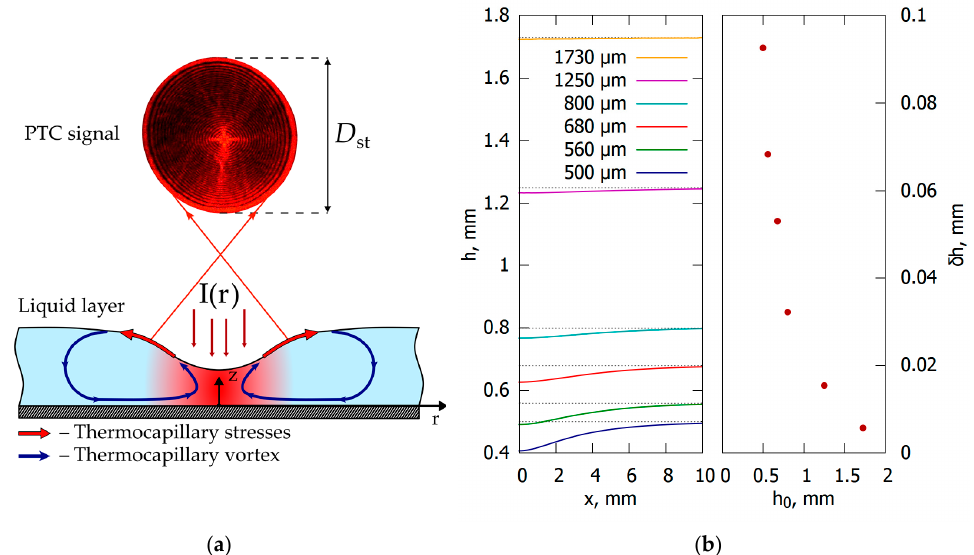
Figure 2. ( a ) Schematic of the thermocapillary convection in a liquid layer locally heated with a laser beam, I ( r ). A thermocapillary concave deformation of the interface in the heated spot and the pho- tothermocapillary signal (PTC signal) formation by a reflected laser radiation; ( b ) typical profiles of the thermocapillary concave deformation of silicone oil layers (500–1730 μ m) induced by heating with the laser beam ( 𝜆 = 532 nm, 𝑃 = 12.7 mW) and the deformation depth, 𝛿ℎ , vs. the layer thick- nesses.